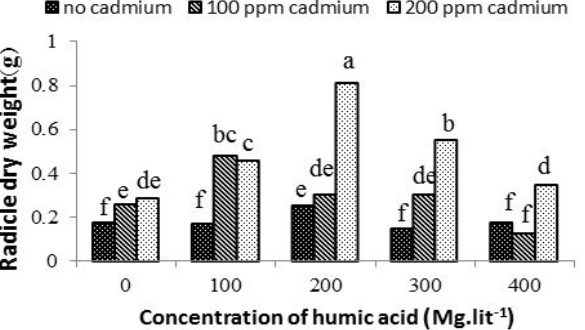
Fig. 5. Effect of humic acid and cadmium concentration on the